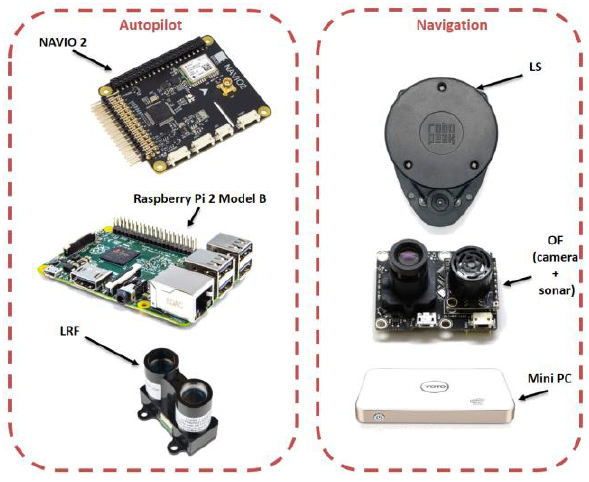
Figure 3. The two main